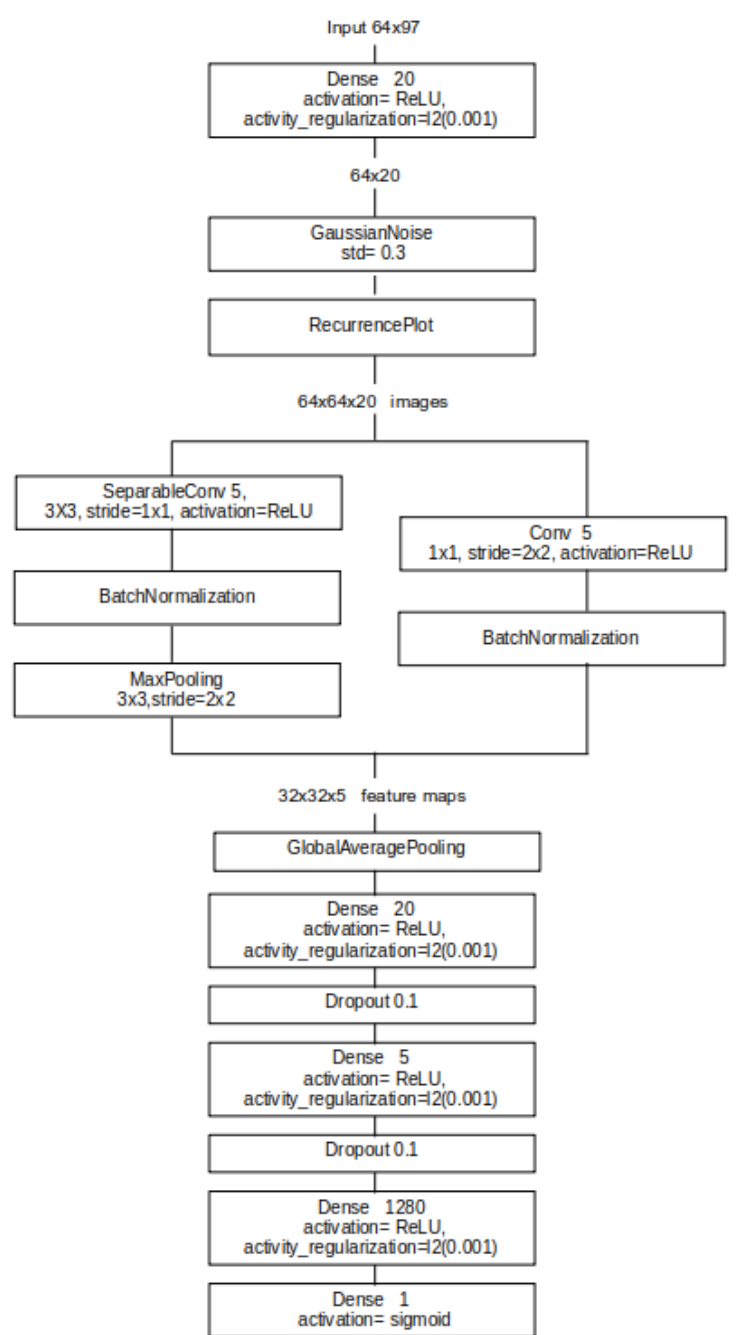
Figure A5. The RPCNN